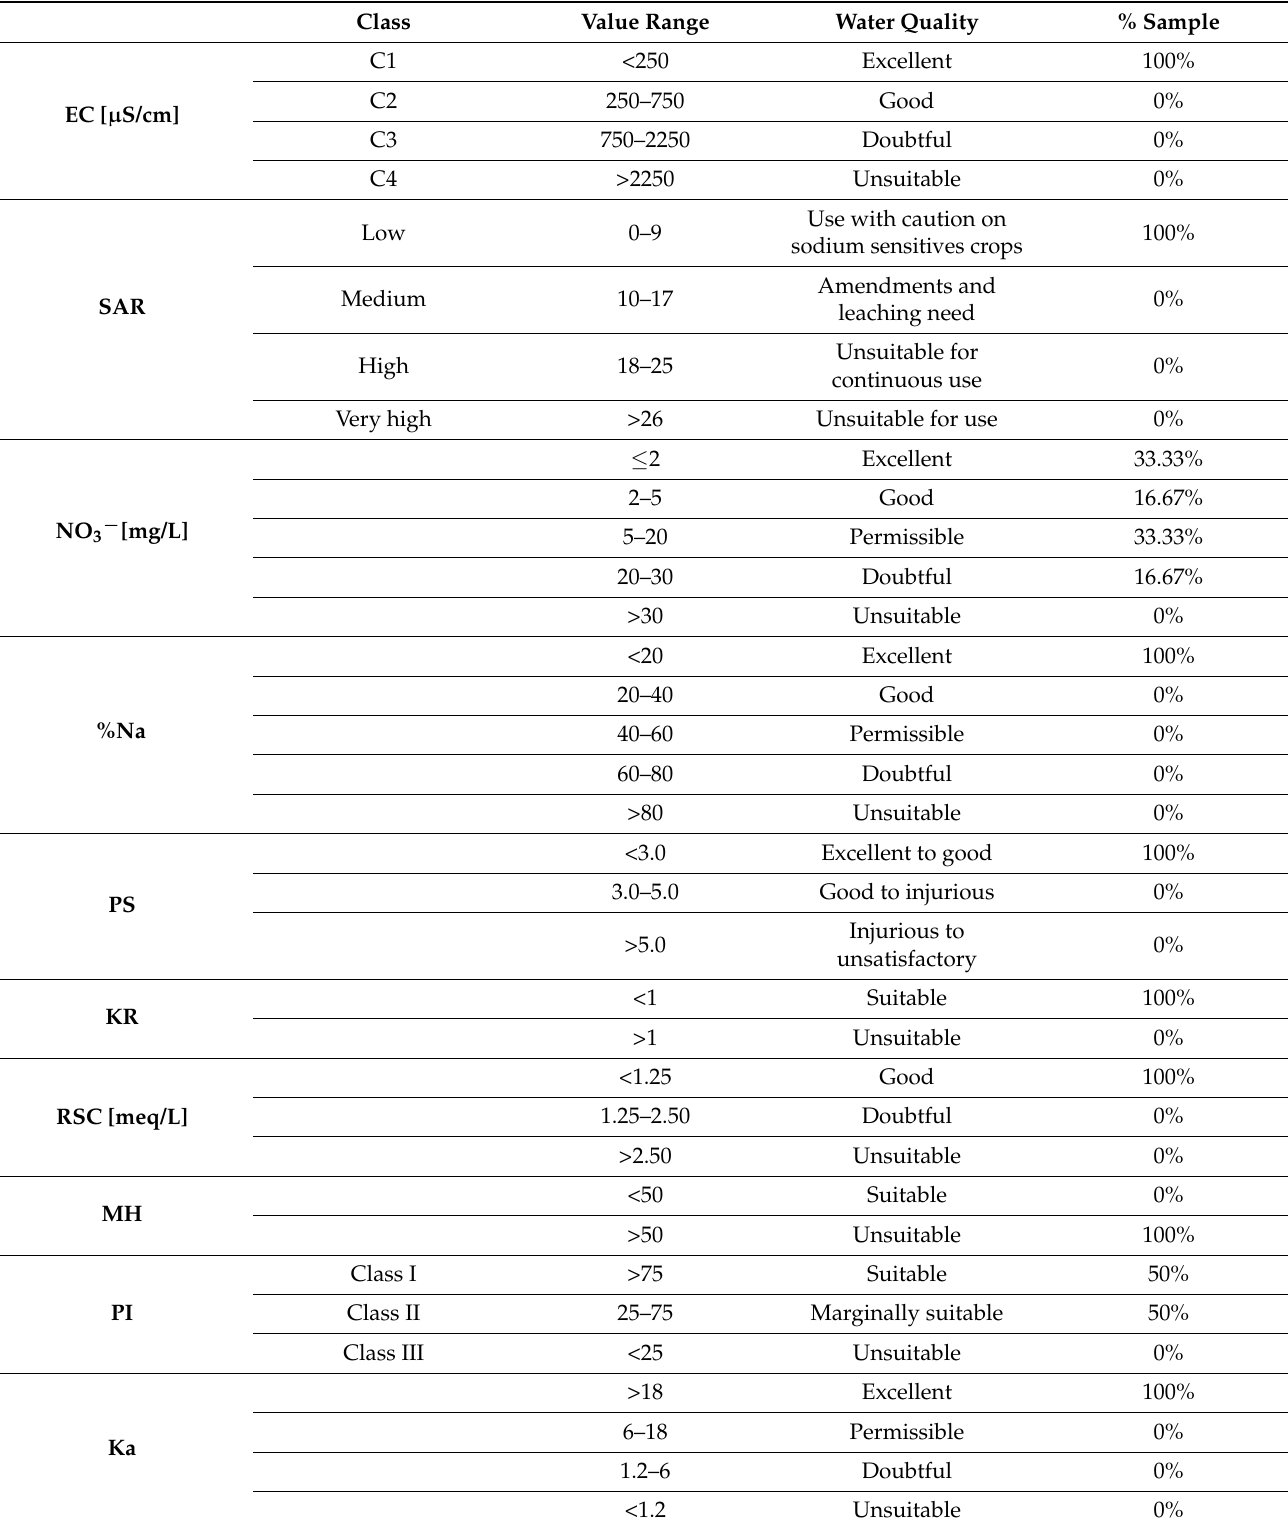
Table 7. Classification of groundwater quality for irrigation based on EC, Na%, RSC, MH, PI, KR, PS, and